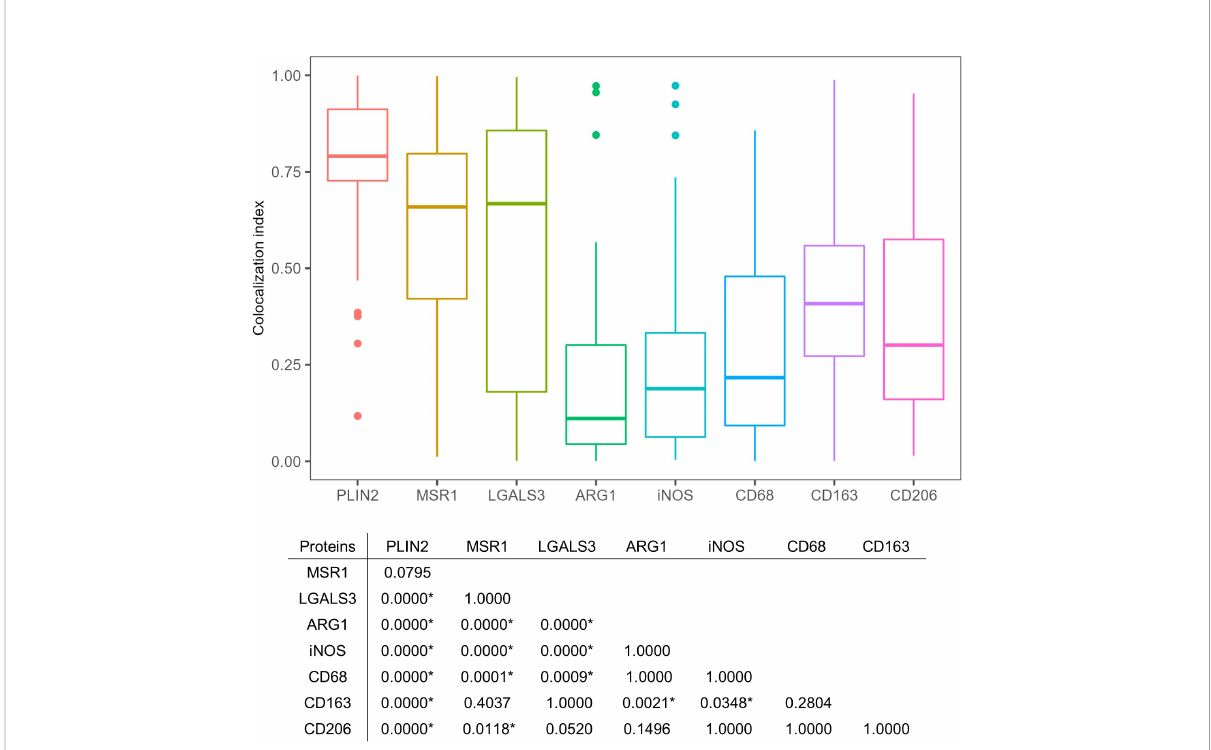
FIGURE 5 Quantitative colocalization of signatures with PLIN2 + cells in necrotic granulomas. The colocalization index was estimated by dividing the area of the indicated marker protein colocalizing with PLIN2 by that of PLIN2 in the image. The colocalization index was calculated from approximately 50 images of cells stained with antibodies against PLIN2 and PLIN2 (PLIN2), MSR1 and PLIN2 (MSR1), LGALS3 and PLIN2 (LGALS3), ARG1 and PLIN2 (ARG1), iNOS and PLIN2 (iNOS), CD68 and PLIN2 (CD68), CD163 and PLIN2 (CD163), and CD206 and PLIN2 (CD206). The results of Dunn ’ s multiple-comparison test between the colocalization indices of the indicated proteins to PLIN2 are also shown. Asterisks indicate signi fi cant differences ( P <